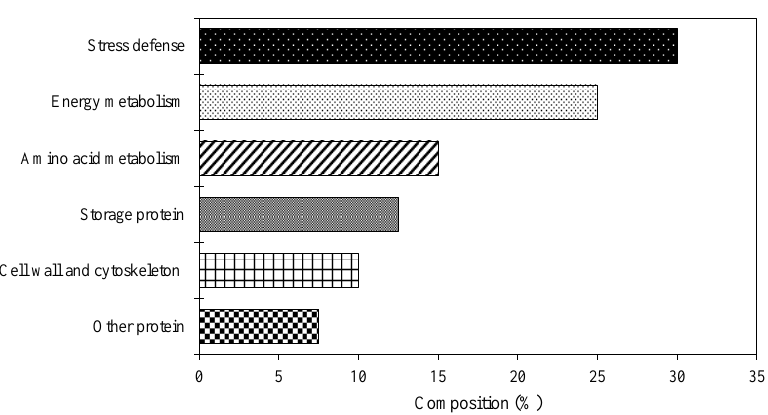
Figure 6. Function-based categorization of proteins expressed differentially in sorghum seed at 24 h after treatment.